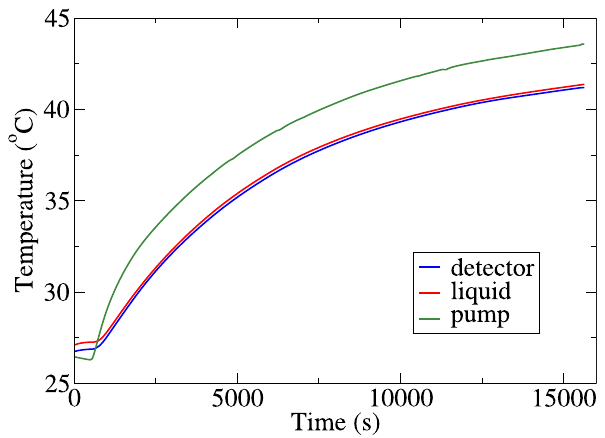
Fig. 9. Temperature ( ◦ C) as function of time ( s ) for the liquid in the reservoir (red), Teflon air pump (green) and detector (blue) during a laboratory measurement.